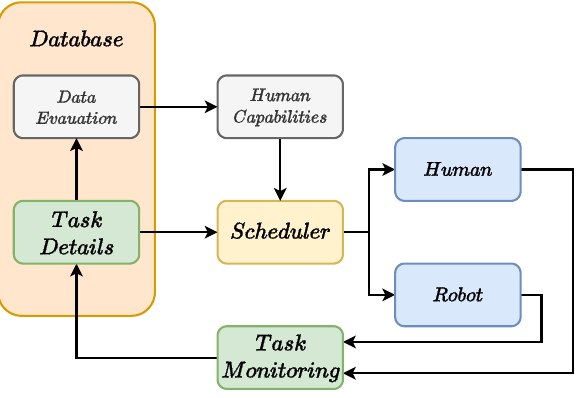
Figure 2. The overall